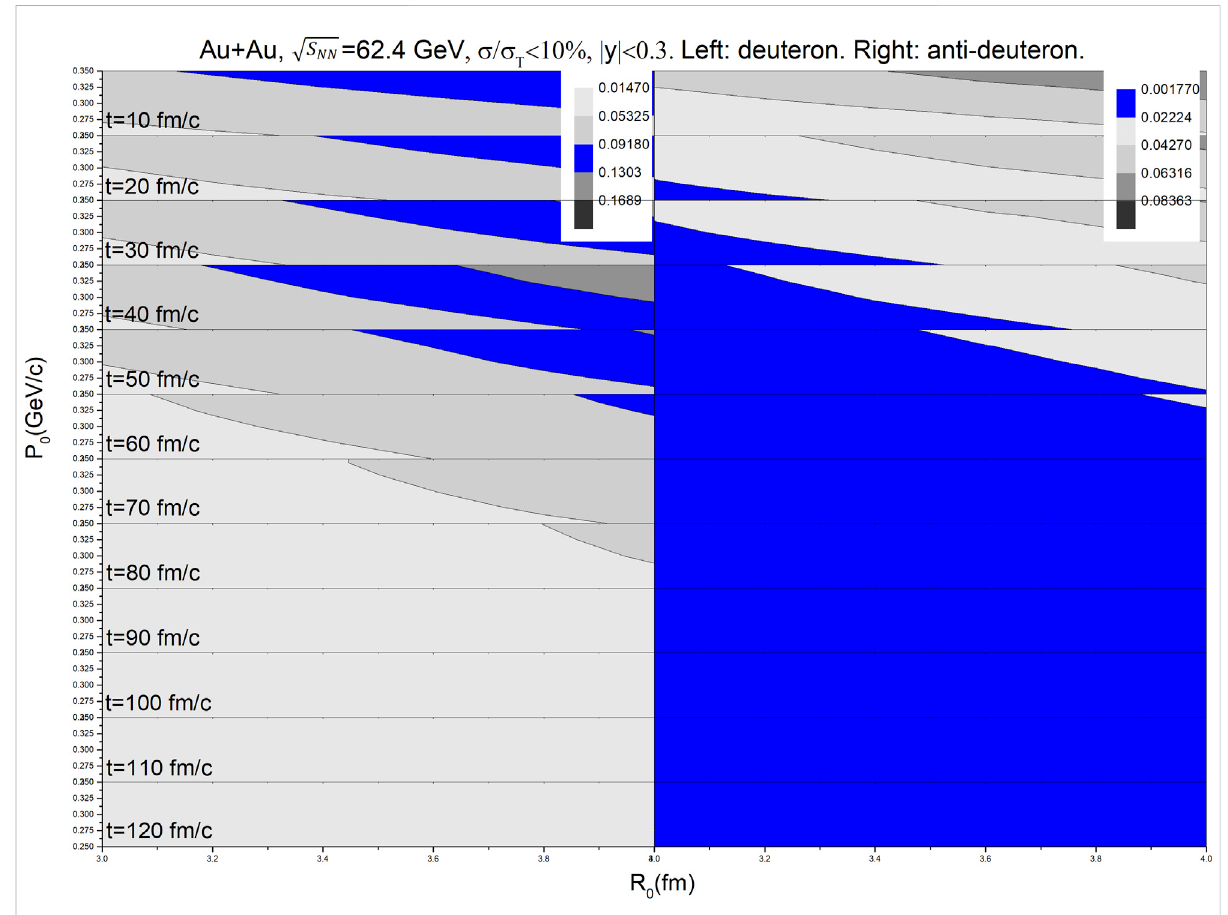
√ (cid:1)(cid:1)(cid:1)(cid:1) s NN = 62.4 GeV. The blue areas represent the